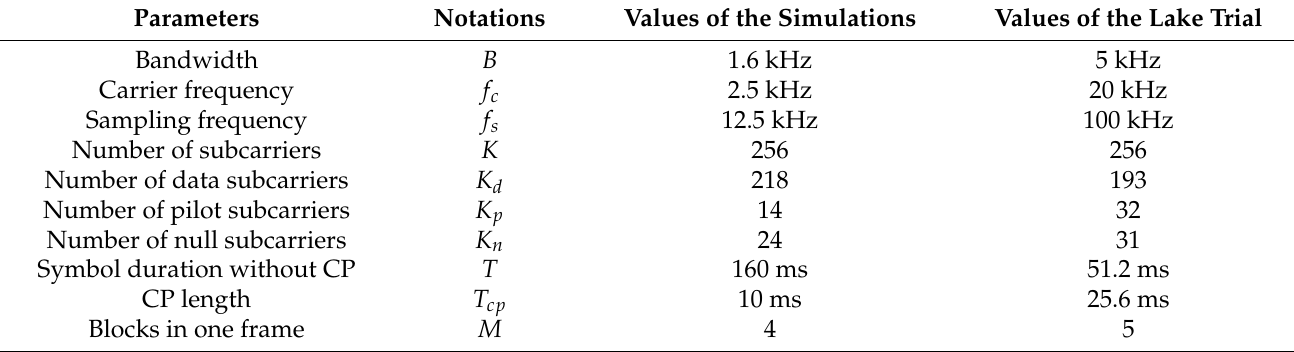
Table 2. UWA CP-OFDM